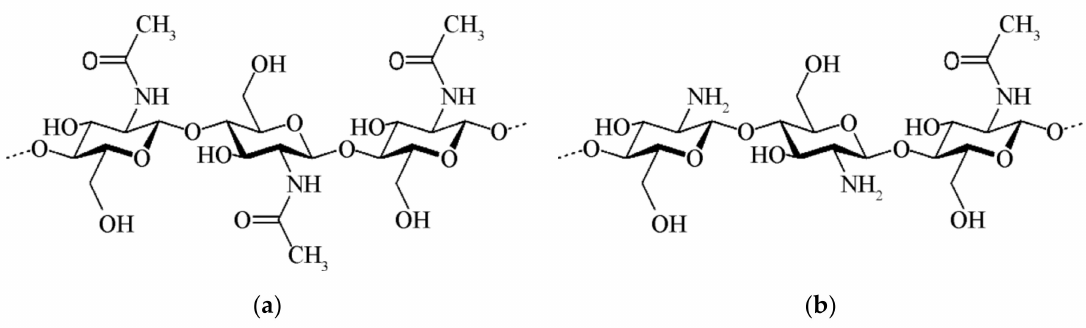
Figure 5. Schematic representation of ( a ) chitin and ( b ) chitosan macromolecules. The degree of acetylation (DA), which is calculated as the proportion of N -acetyl- d